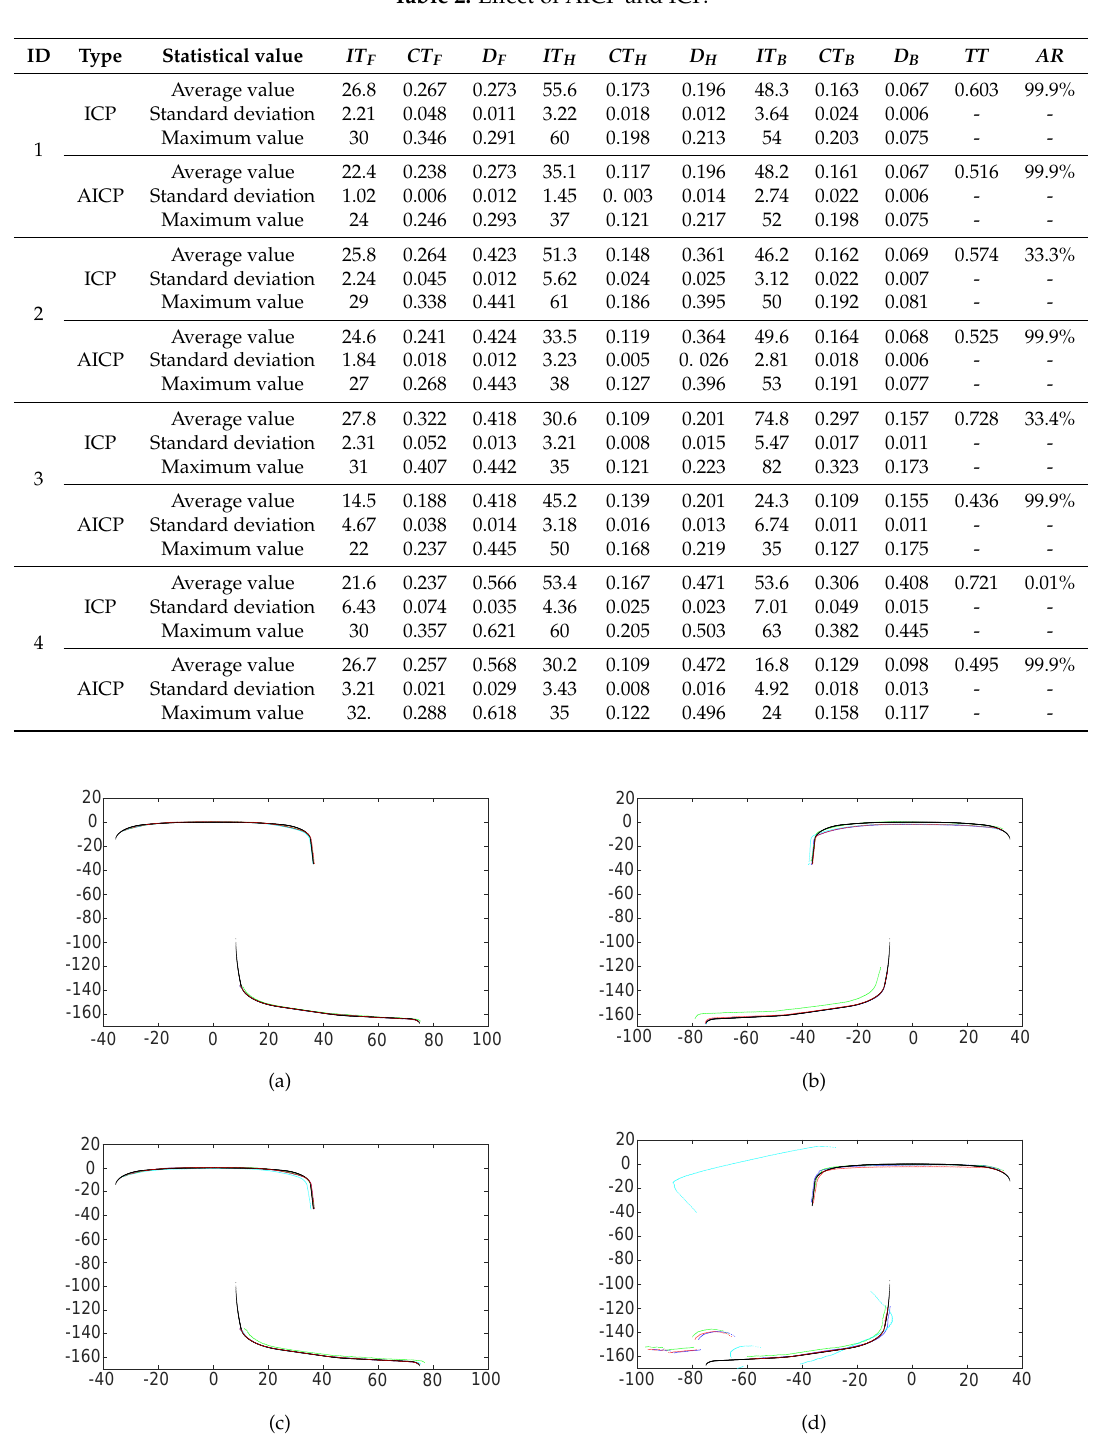
Figure 9. Result of ICP and AICP: ( a ) With less defects; ( b ) With defects on the rail head; ( c ) With defects on the rail bottom; ( d ) With defects on both the head and